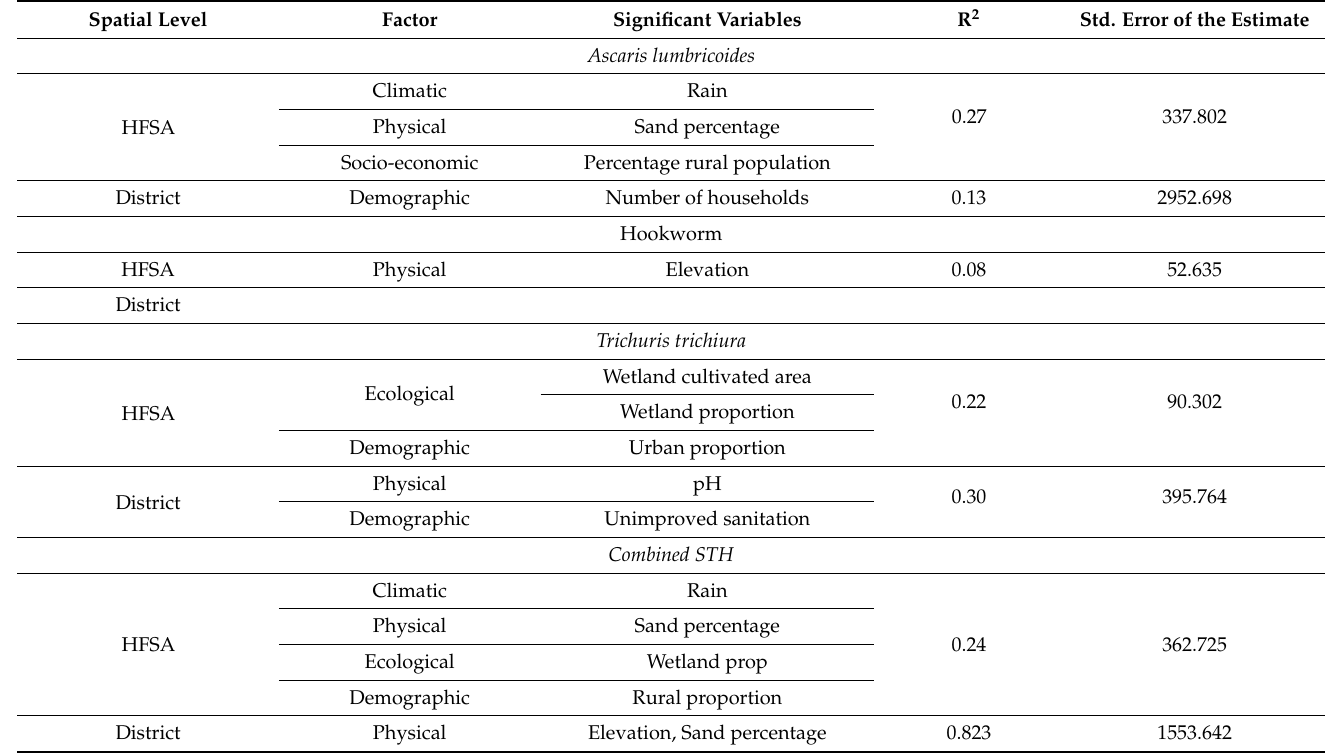
Table 4. Summary of linear regression models for incidence rates per STH